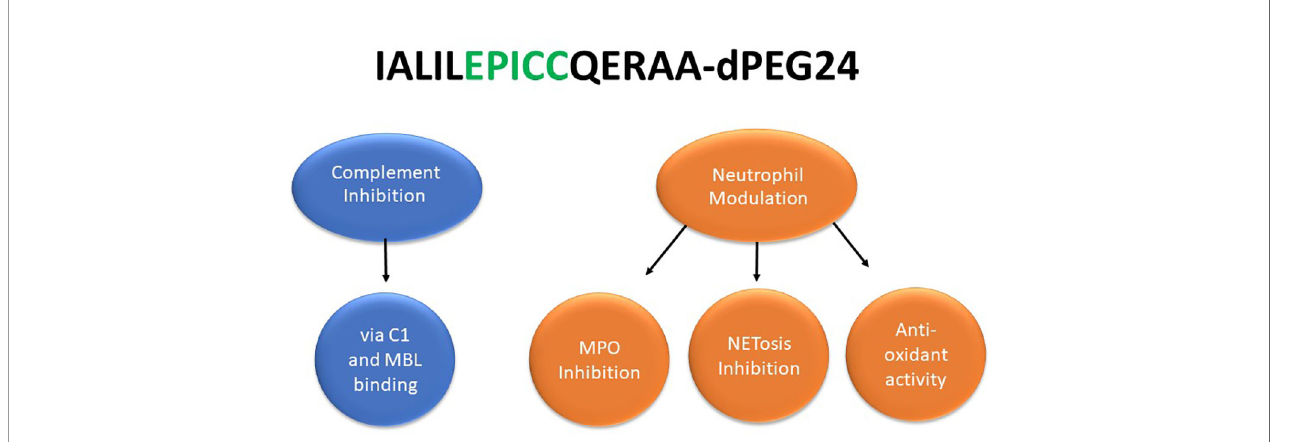
FIGURE 5 | EPICC peptides possess novel dual acting anti-in fl ammatory activities. The EPICC molecules can block activation of the classical and lectin complement pathways by binding the initiator molecules C1 and MBL, respectively. EPICC peptides also demonstrate inhibition of MPO and NETosis through direct binding of the heme ring of MPO. These peptides also possess antioxidant activity mediate by the vicinal cysteines at positions 9 and 10 of the peptide. The sequence of the 15 residue EPICC molecule, RLS-0071 containing the C-terminal dPEG24 moiety, is